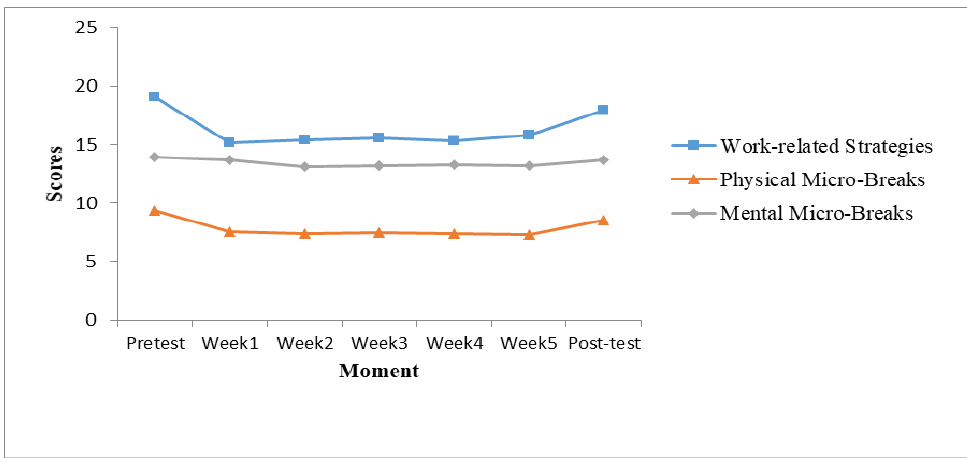
Figure 3 . Evolution of the energy management strategies scores during the pre-test, post-test, and the 5-week self-monitoring phase .